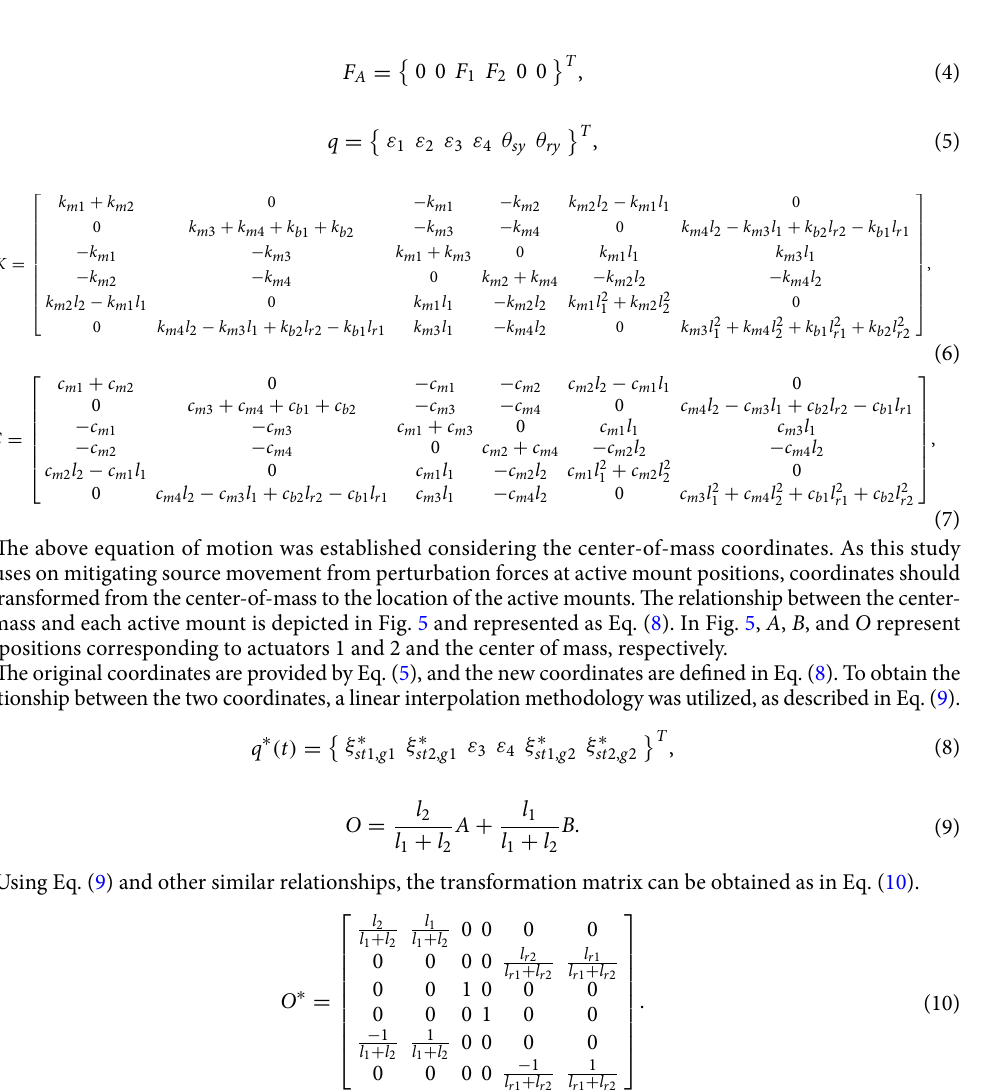
Applying Eq. (10), the coordinate transform is performed, and it is defined as q = O ∗ q ∗ , where q ∗ is defined in Eq. (10). Thus, in order to consider the transformed coordinates, Eq. (1) is re-written in relation to the active mount coordinates, defined in Eq. (11), where M ∗ = MO ∗ , C ∗ = CO ∗ , and K ∗ = KO ∗ . Furthermore, Fig. 6 shows the transformed coordinates.